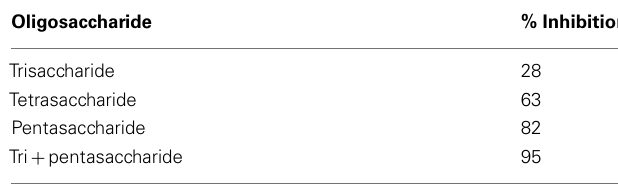
Table 1 | Maximum inhibition (%) of S. schenckii peptidorhamnomannan immunoprecipitation with its derived O -linked oligosaccharides (at 1 μ